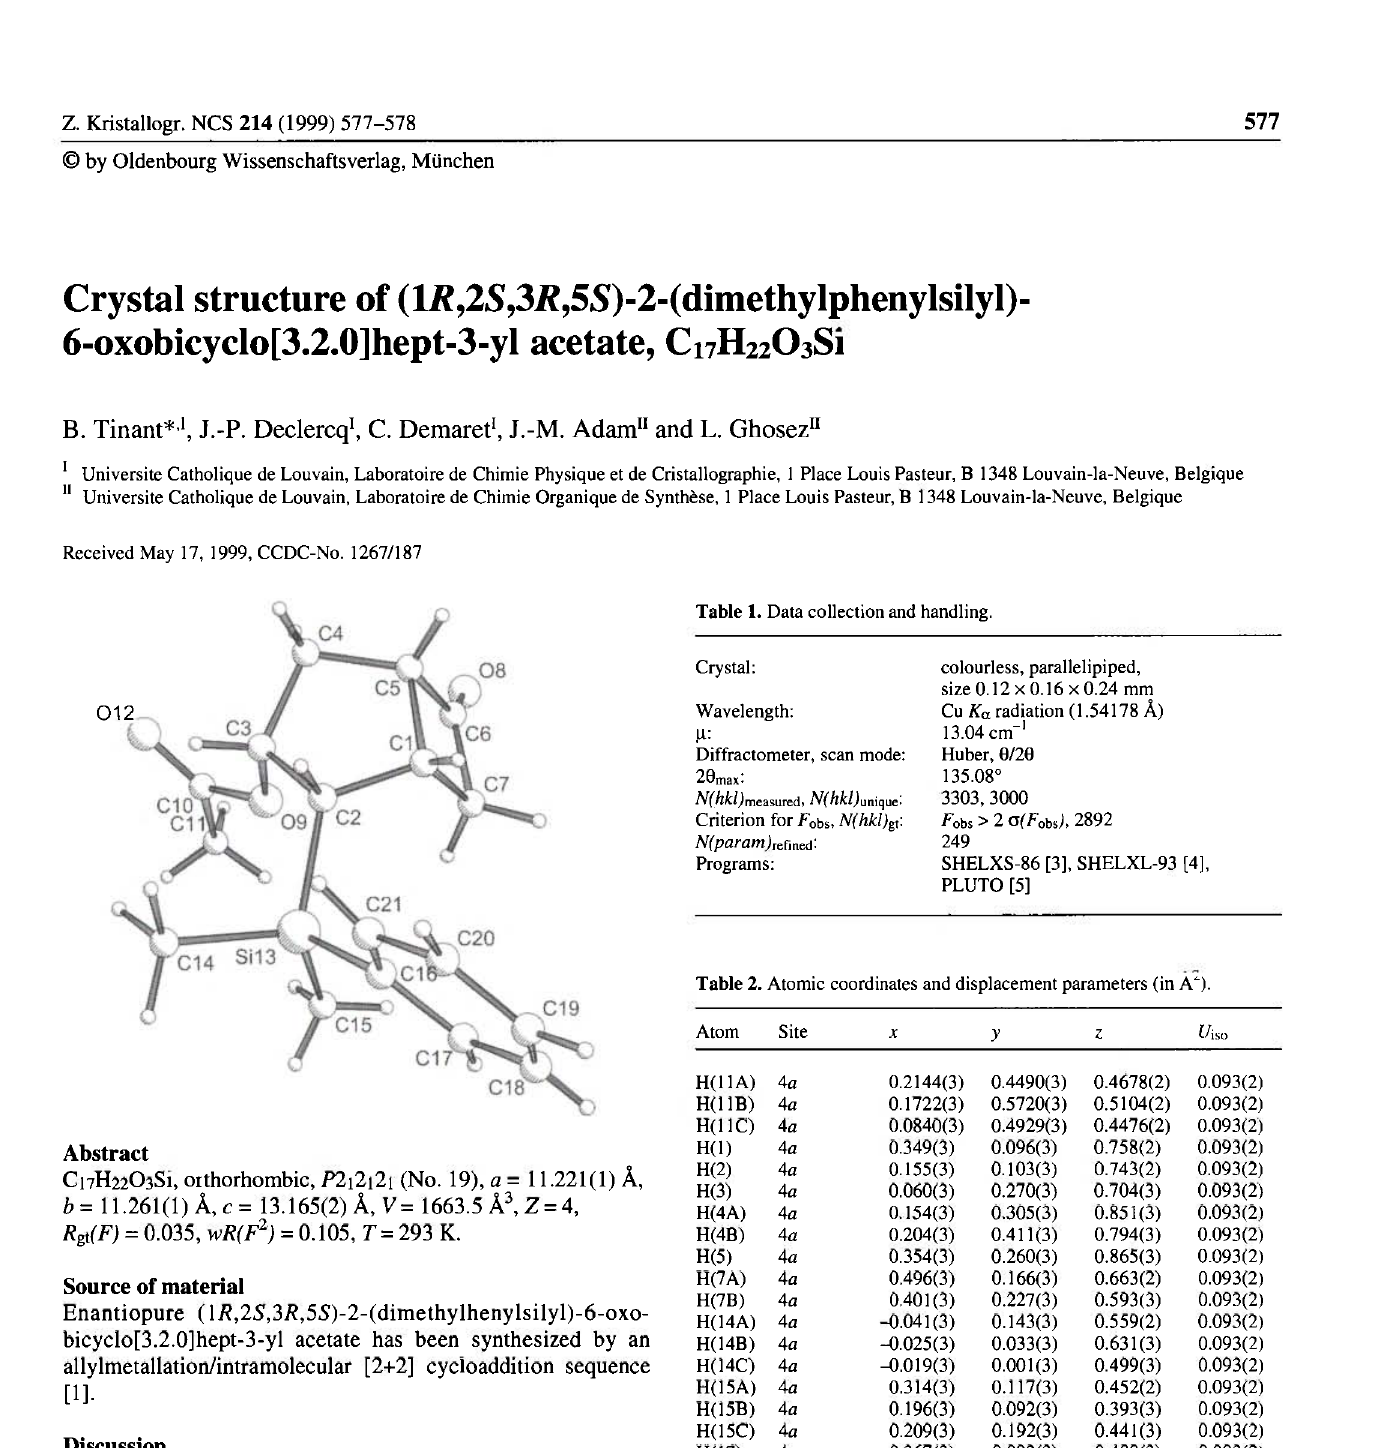
Table 3. Atomic coordinates and displacement parameters (in Ä 2 ).